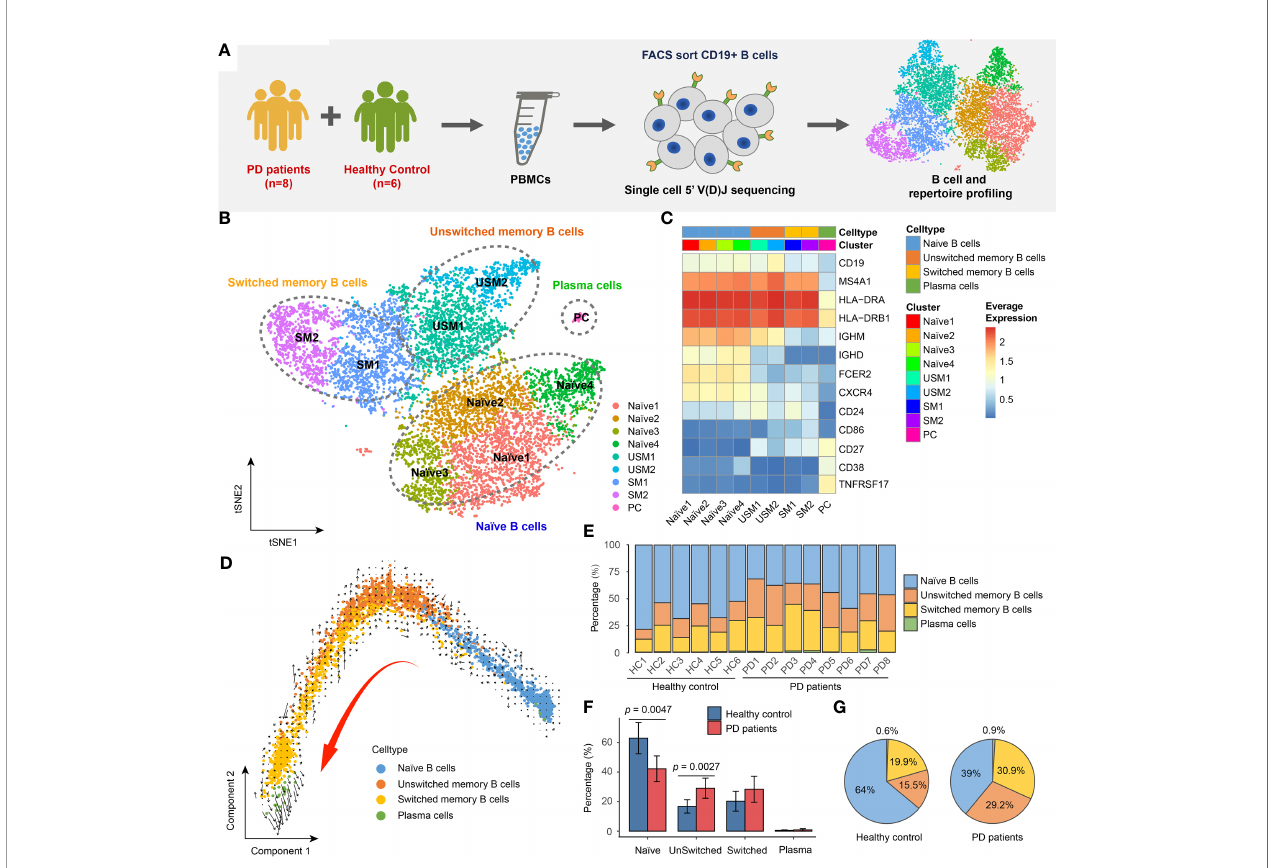
FIGURE 1 | Landscape of Peripheral blood B cells in Parkinson ’ s disease revealed by single-cell transcriptome sequencing. (A) Overview of experimental design. CD19+ B cells were sorted by FACS and then subjected to single-cell RNA and V(D)J sequencing. (B) tSNE projection of 10,466 single B cells, showing 9 distinct clusters. (C) Heatmap shows the average logCPM of classical marker genes for all 9 cell clusters. (D) The velocities are visualized on the fi rst two principal components calculated by monocle. (E) Bar chart shows the percentages of four major types of B cell in each sample. (F) Bar plot shows the average percentages of four major B cell types in PD patients and healthy controls. Error bars represent the standard deviation. (G) Pie charts show the percentage composition of B cells in PD patients and healthy